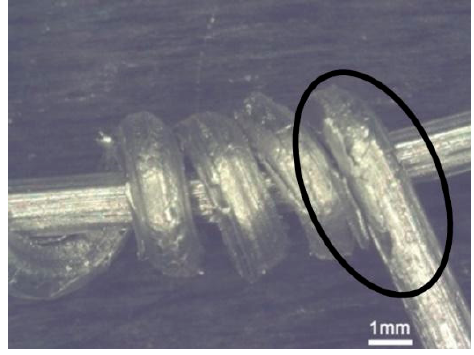
Figure 9. 1.00 wt.% MoB 2 .